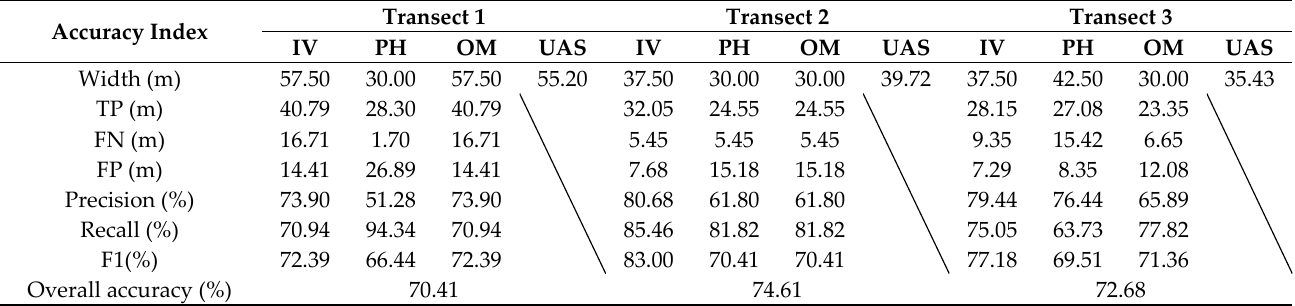
Table 3. Test the accuracies of ecotones width derived from UAS at corresponding transect in different data. For the meaning of TP, FN, and FP, refer to the accuracy assessment section above.